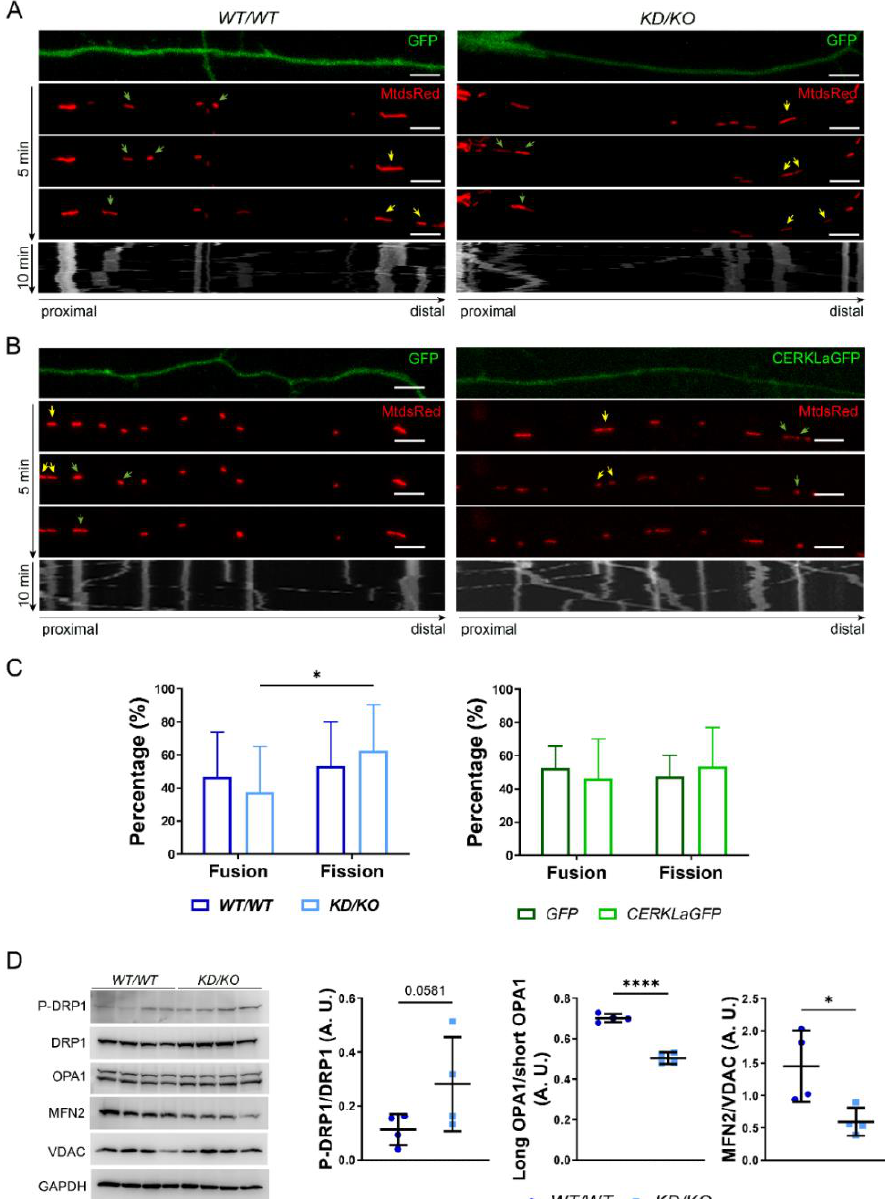
Figure 6. Mitochondrial fission is increased in the axons of KD / KO hippocampal neurons . Mito- chondrial trafficking live imaging (representative images of different timepoints over 5 min) from axons of primary hippocampal neurons in order to analyse mitochondrial fusion (green arrows) and fission (yellow arrows) events in ( A ) CERKL overexpression conditions, comparing GFP-(control) and CERKLa-GFP-transfected neurons; and ( B ) CERKL depletion conditions, comparing WT / WT and KD / KO hippocampal axons. Mitochondria were stained with MitoDsRed. Scale bars: 5 µ m. Ky- mographs showing the path of each mitochondrion along the axons for 10 min. ( C ) The percentage of fission events is increased in KD / KO hippocampal axons, whereas it remains unchanged in CERKLa- GFP-transfected hippocampal neurons, compared to their respective controls. Statistical analysis by two-way ANOVA. n = 23 axons per genotype, n = 14–15 axons per condition. ( D ) Mitochondrial fusion/fission proteins are altered in KD / KO hippocampi. Western blot analysis and quantification of P-DRP1, total DRP1, OPA1 and MITOFUSIN2 proteins in WT / WT and KD / KO hippocampi lysates show: an increase of P-DRP1/DRP1, and a decrease in long OPA1/short OPA1 and MFN2 levels in KD / KO samples. Statistical analysis by t -test. n = 4 animals per genotype. *: p -value ≤ 0.5; ****: p -value ≤